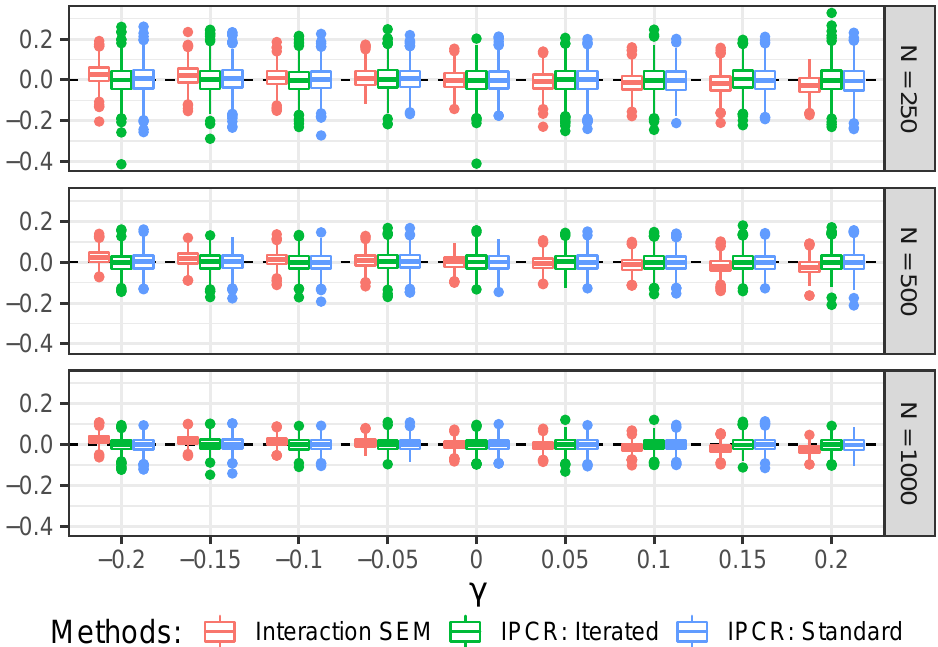
Figure 12. Boxplots with the bias of the estimates of the dependency γ ( y -axis) for different values of γ and sample